Question: Author a descriptive caption for the visualization shown.
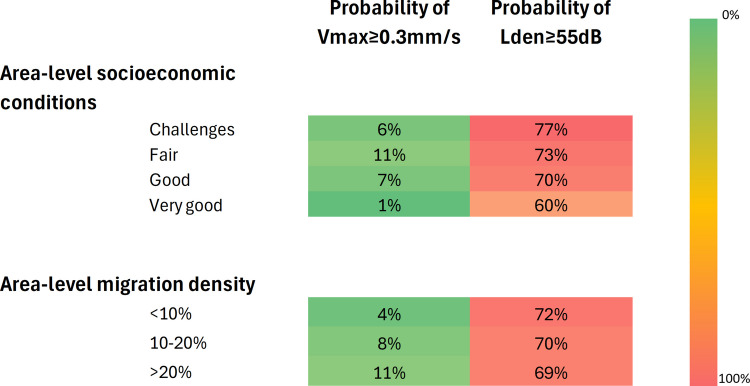
Answer: Colour-coded table of the predicted probabilities of exposure to noise ≥ 55 dB and vibration ≥ 0.3 mm/s Vmax. Probabilities were predicted based on logistic regression models